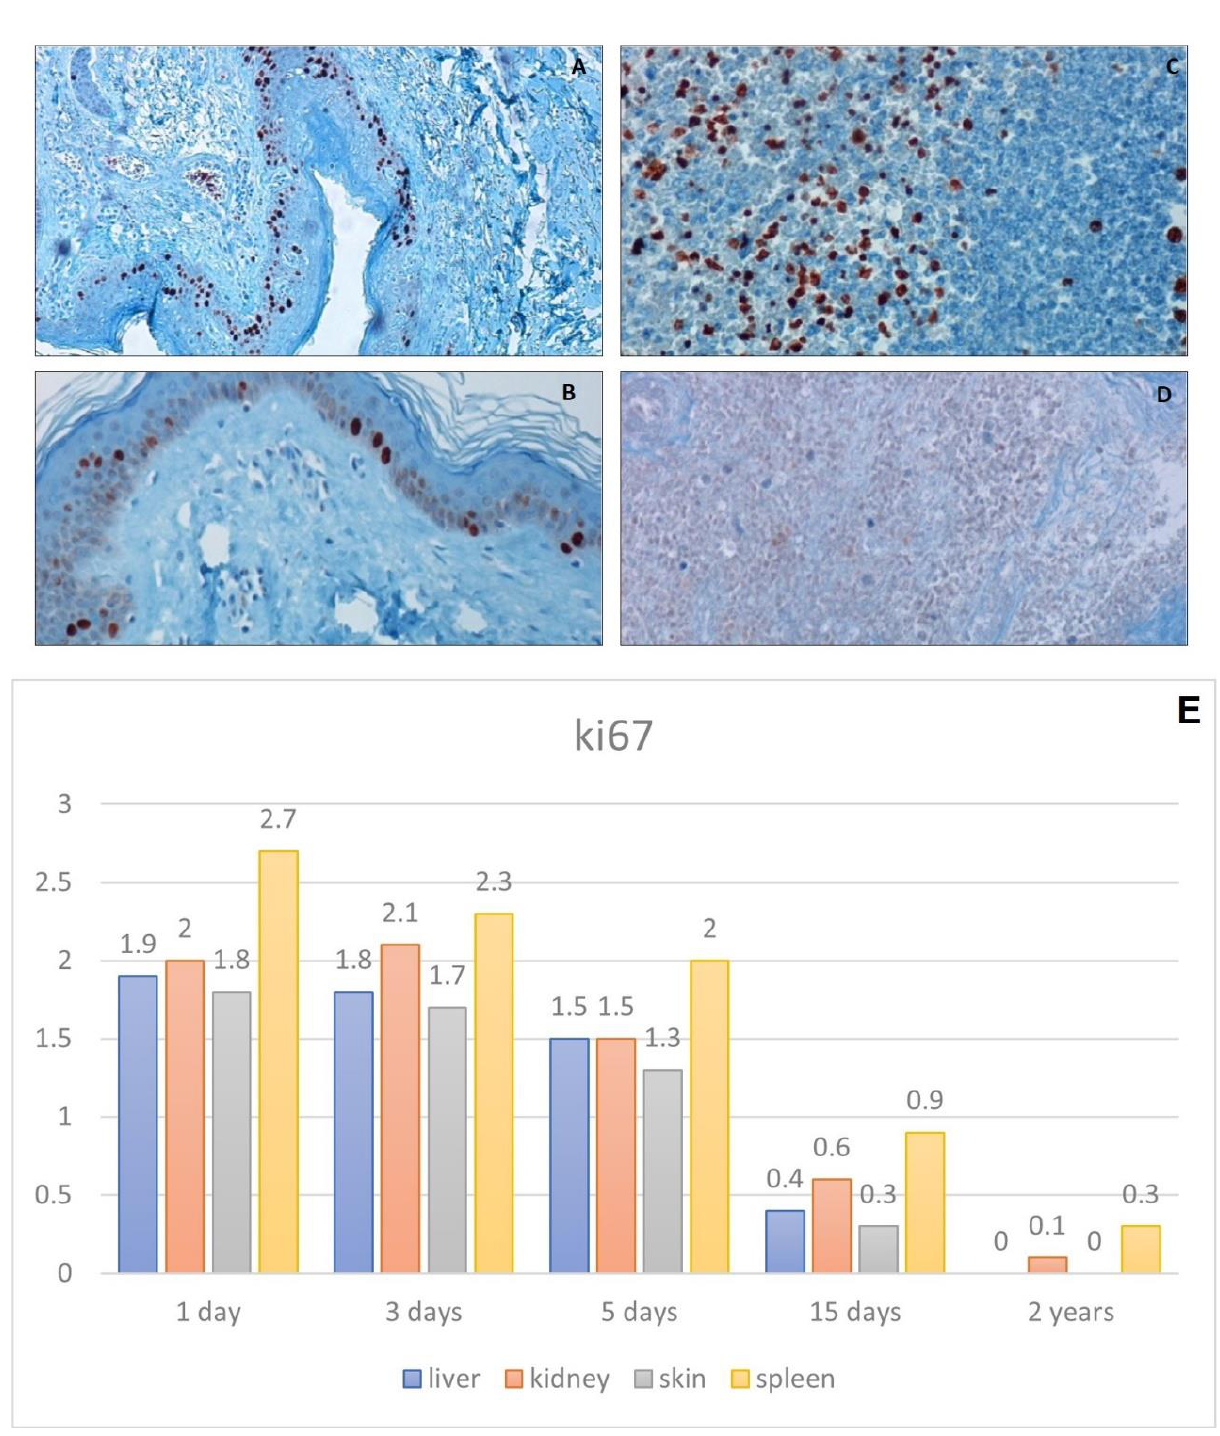
Figure 6. Immunohistochemical analysis of ki 67. ( A ) high nuclear Ki67 expression in skin taken 1 day after death, 10 × . ( B ) Reduction of nuclear Ki67 expression in skin taken 5 day after death, 10 × . ( C ) Ki67 nuclear expression in spleen lymphocytes (3 days after death). 20 × ( D ) No Ki67 nuclear staining in a spleen sample taken 5 days after death, 10 × . ( E ) Graph shows the intensity of ki67 immunostaining (score